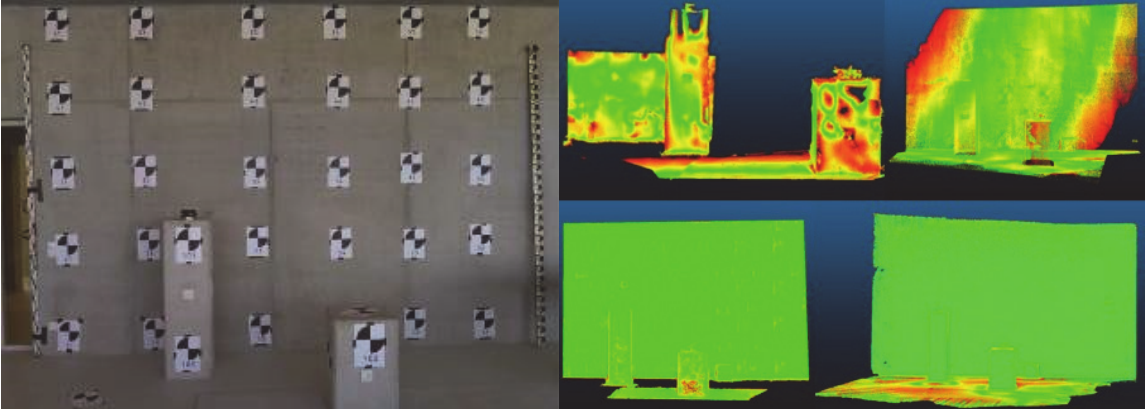
Figure 7. 3D test field of HCU Hamburg (left), deviations in the test field (right): 3D comparison using CloudCompare (reference vs. test data) – Google Tango (top left), DPI-7 HSBO (top right), Nikon D800 (bottom left) and Kinect v2 (bottom right),